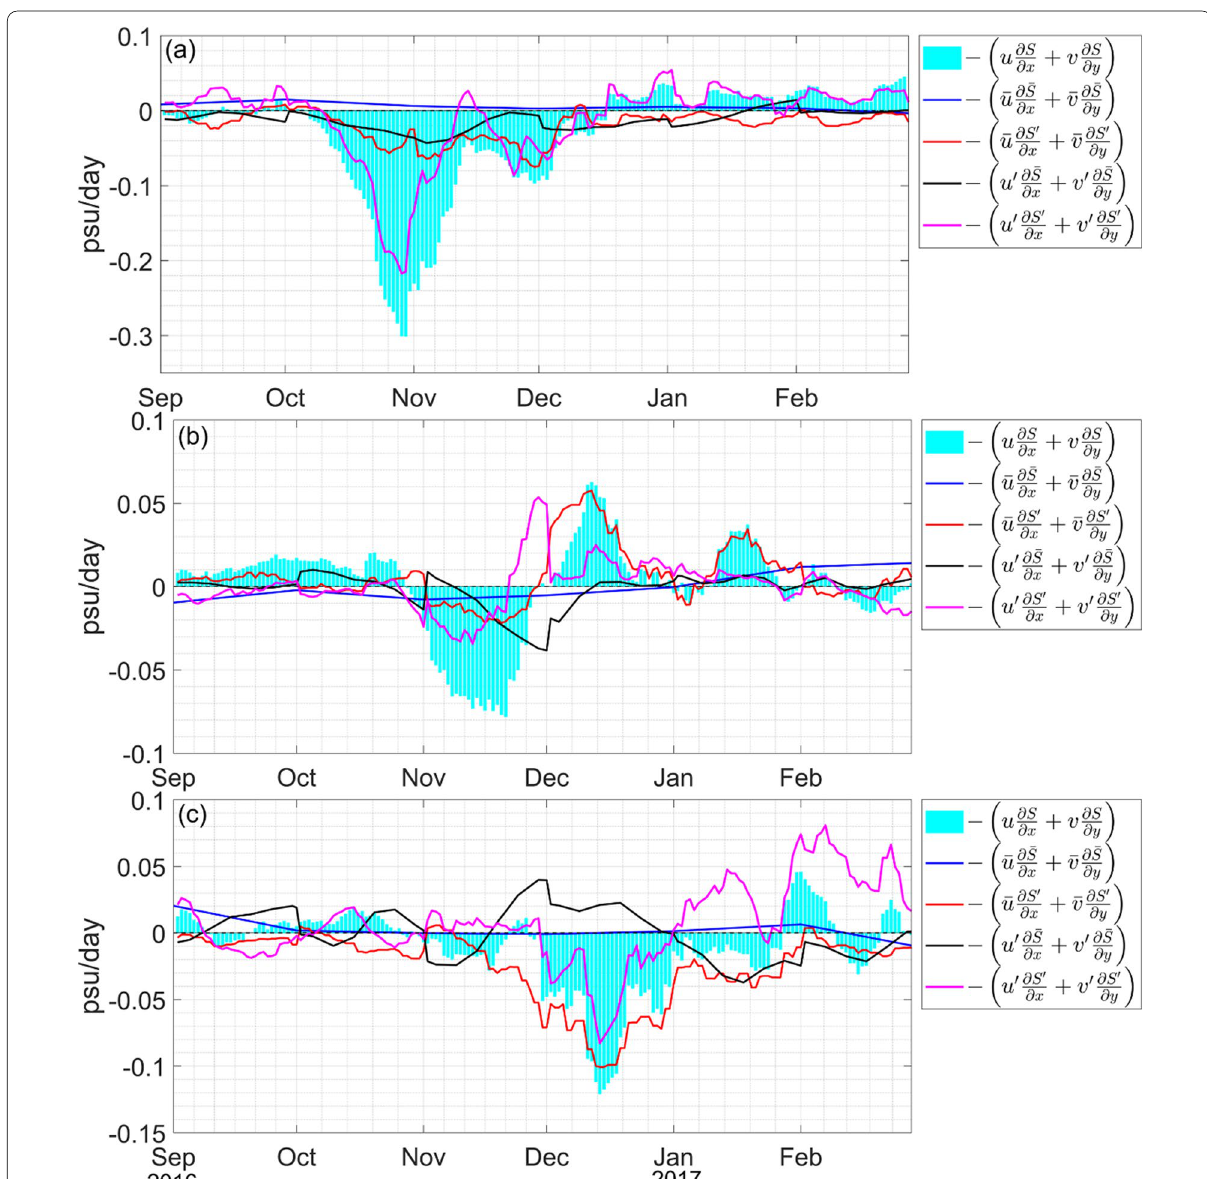
Fig. 7 Time series of components of horizontal advection in three regions along the pathway of the low-salinity water transport from September 2016 to February 2017. a Region A (80°–83°E, 8°–15°N); b Region B (74°–82°E, 3–8°N); c Region C (72°–77°E,